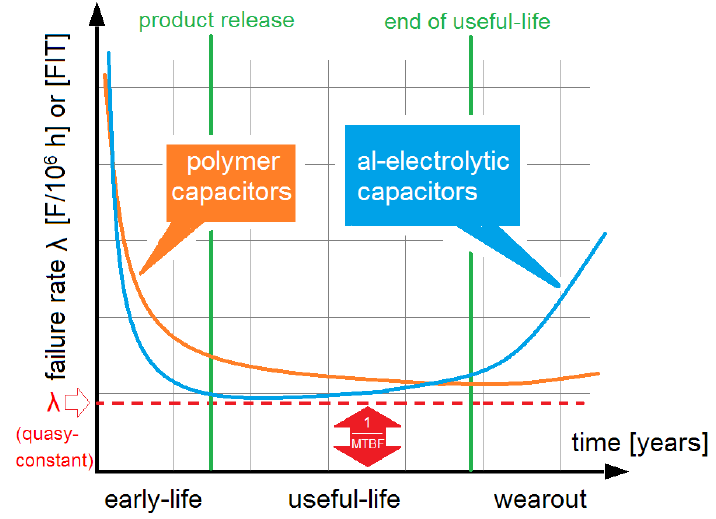
Figure 1. The bathtub curve: failure rate λ is assumed to be a quasi-constant value during the useful life only.